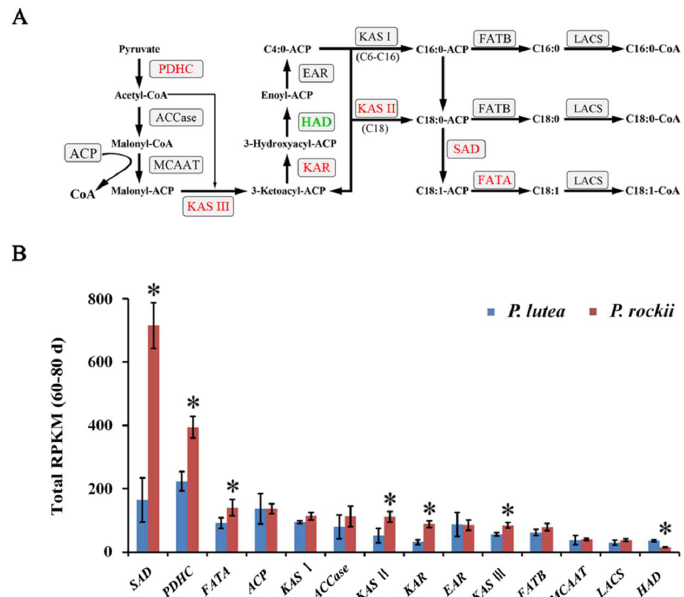
Figure 3. Differential lipid gene expression in plastid between the two species. ( A ) Schematic outline Figure 3 of the genes encoding for fatty acid biosynthesis in plastid and ( B ) their total RPKM during 60 to 80 days of developing seeds. For gene abbreviations see Table S4. Genes represented in red letters indicate significant difference in their expression levels between the two species, with a ratio of P. rockii to P. lutea ≥ 1.5, and genes represented in green letters indicate the P. rockii is significantly lower than P. lutea in their expression levels. RPKM: reads per kilobase per million. The asterisks indicate significant differences (* p < 0.05, Student’s t -test).